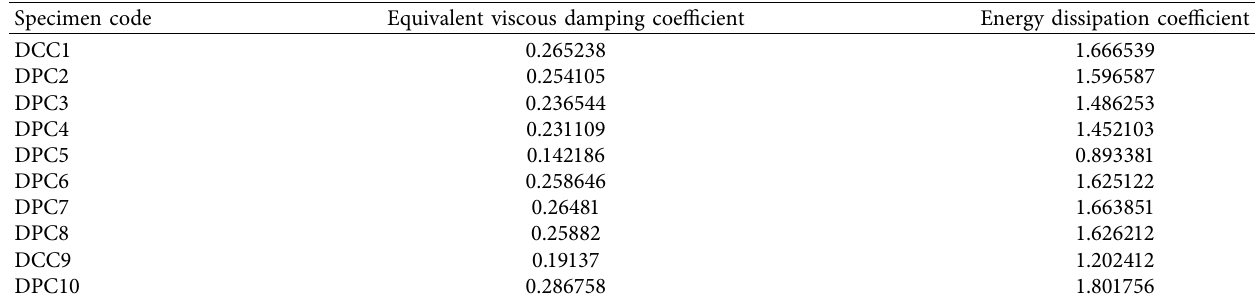
Table 6: Energy dissipation capacity of the